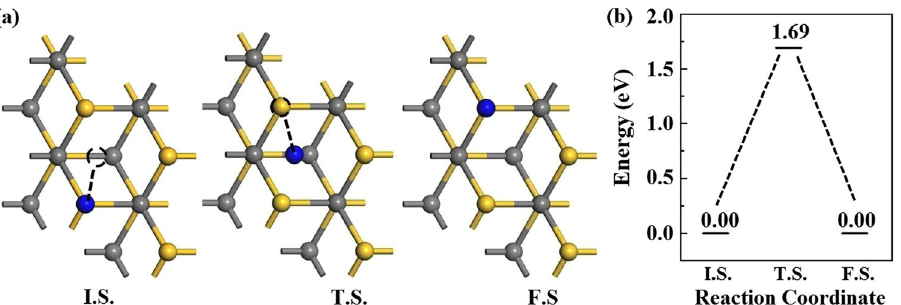
Figure 2. Migration pathway ( a ) and energy barrier ( b ) for the diffusion of H atom on SiC (0001) surface. The blue balls denote the H atoms, the gray balls denote the C